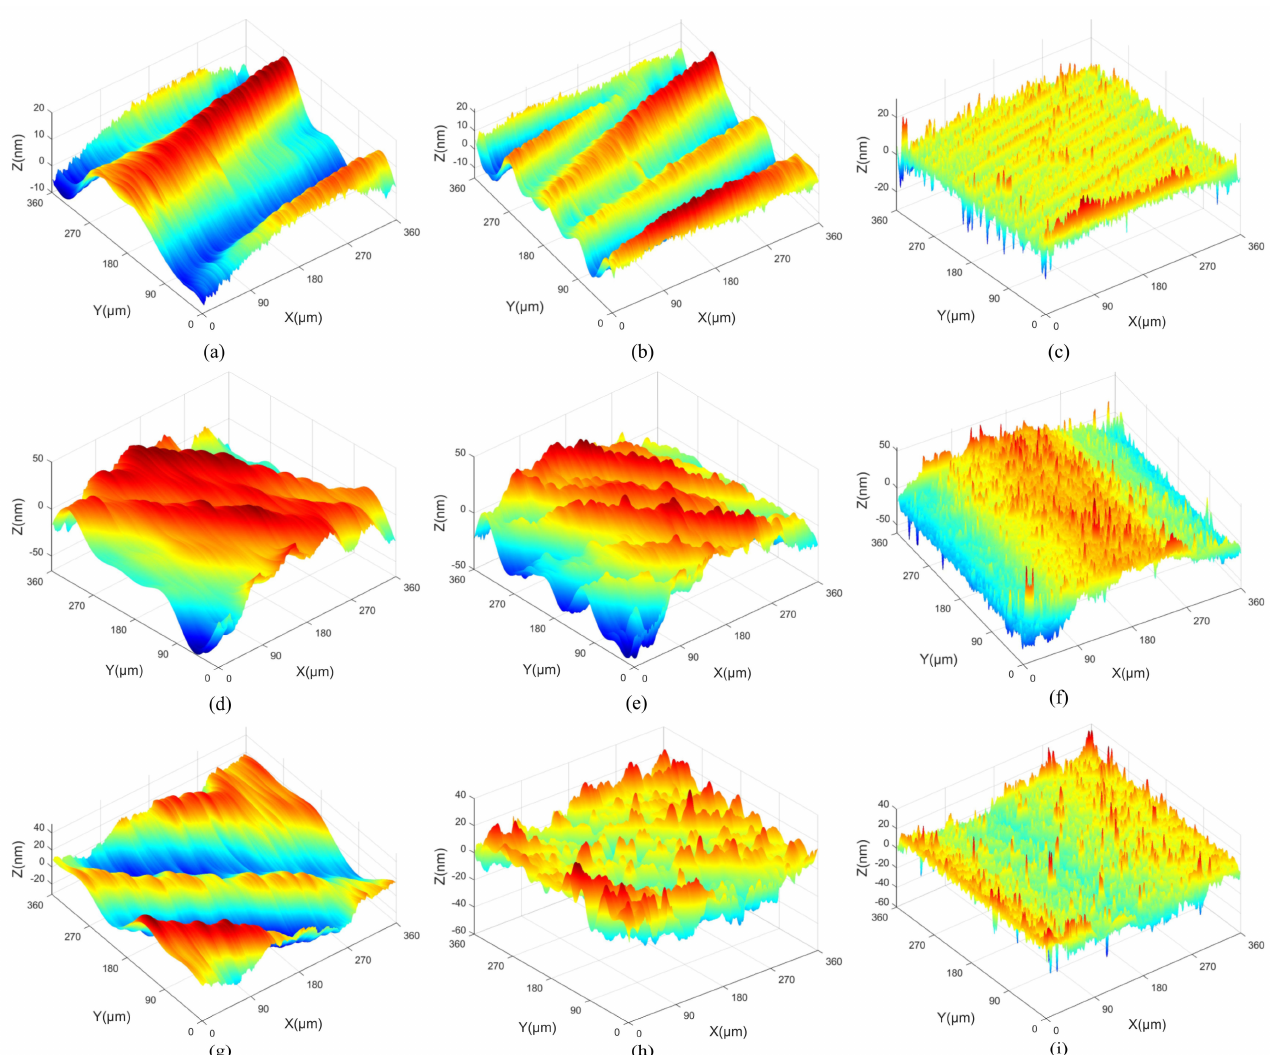
Figure 8. The reconstruction results of spatial frequency features with different feed rates: ( a ) low- frequency of f = 8 µ m/r, ( b ) middle-frequency of f = 8 µ m/r, ( c ) high-frequency of f = 8 µ m/r, ( d ) low-frequency of f = 12 µ m/r, ( e ) middle-frequency of f = 12 µ m/r, ( f ) high-frequency of f = 12 µ m/r, ( g ) low-frequency of f = 18 µ m/r, ( h ) middle-frequency of f = 18 µ m/r, ( i ) high-frequency of f = 18 µ